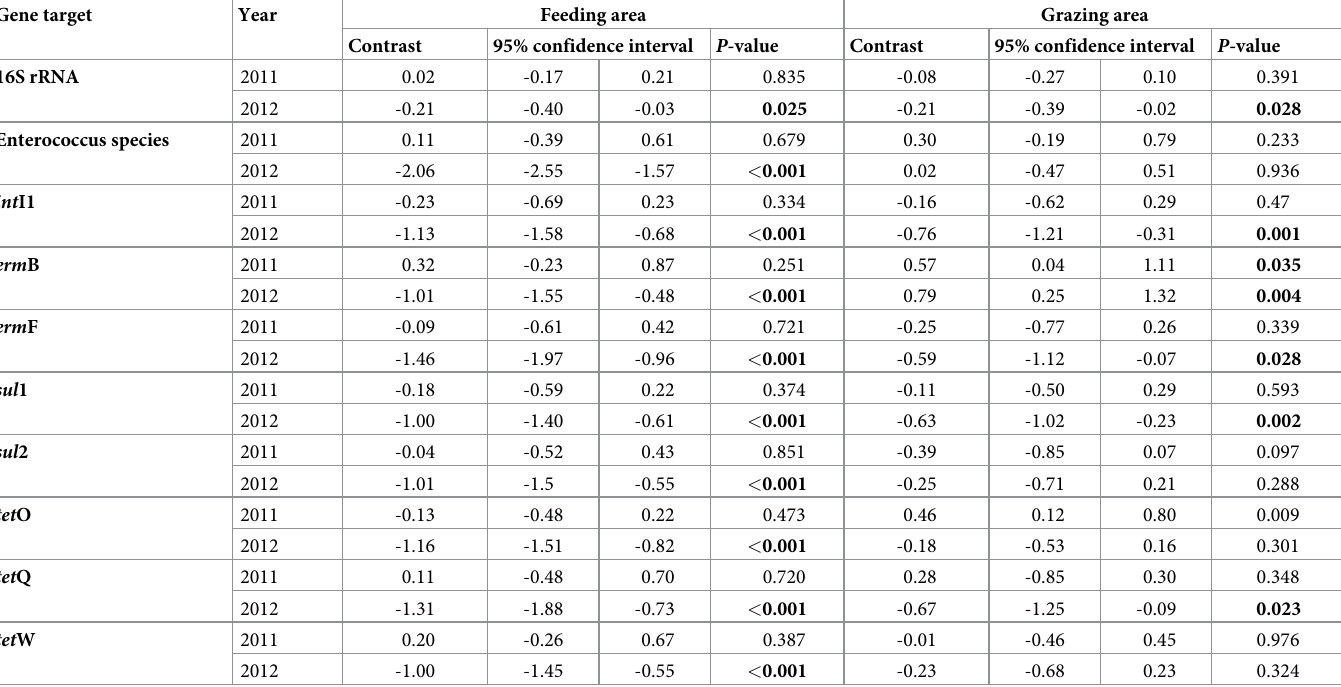
Table 2. Change in log 10 copies of antibiotic resistance genes over two years after cessation of the beef cattle backgrounding operation compared to 2010 level. Gene